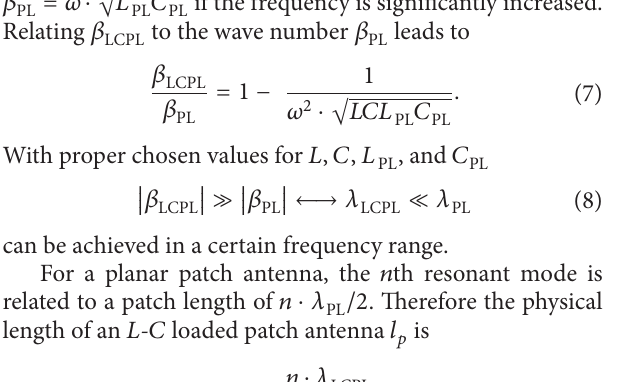
Figure 5: Simulated return loss bandwidth ( 𝑆 11 < −10 dBi) of the recommended